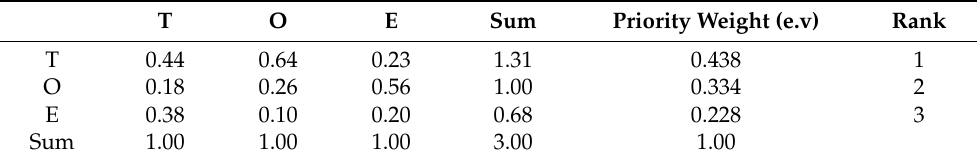
Table 2. Rank of